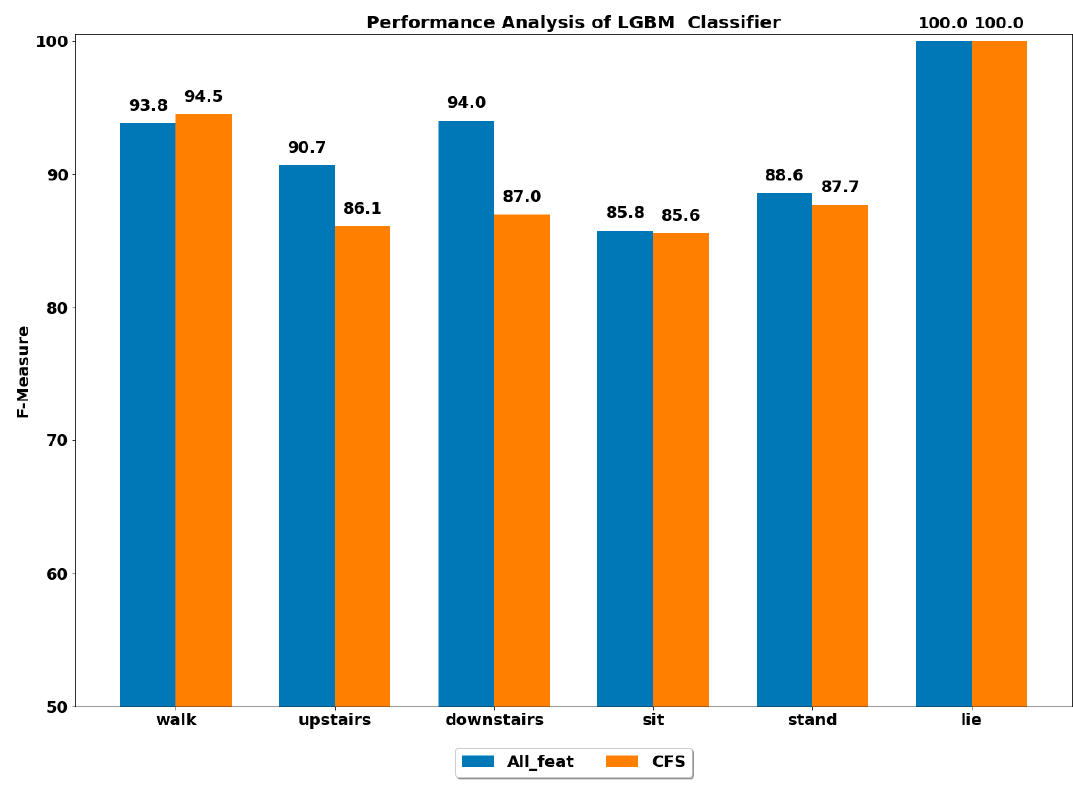
Figure 3. Performance analysis of XGB (extreme gradient boosting) classifier with and without feature selection to classify set of ADLs (activities of daily living).